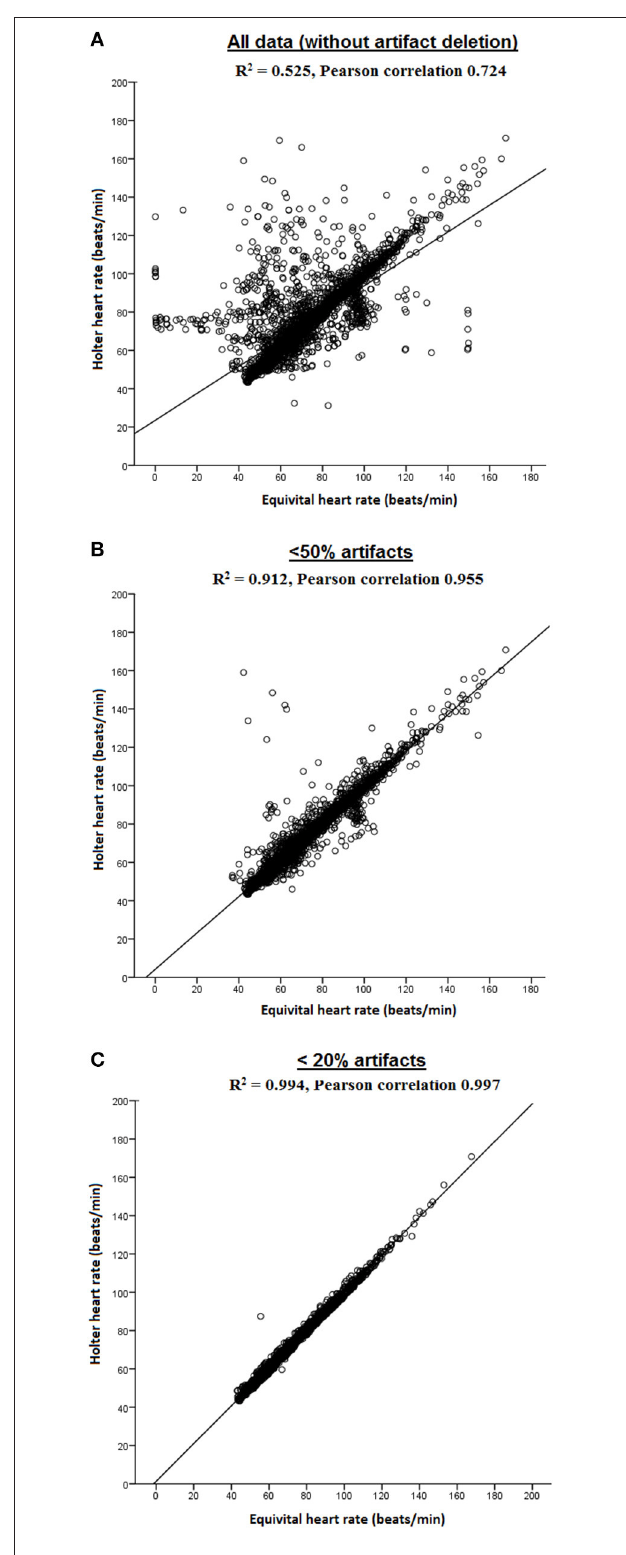
FIGURE 3 | Pearson correlations of HR measured by EQ02 and Holter. Both R 2 and Pearson correlation coefficients are shown for (A) all data, and filtered data containing (B) < 50% artifacts and (C) < 20%